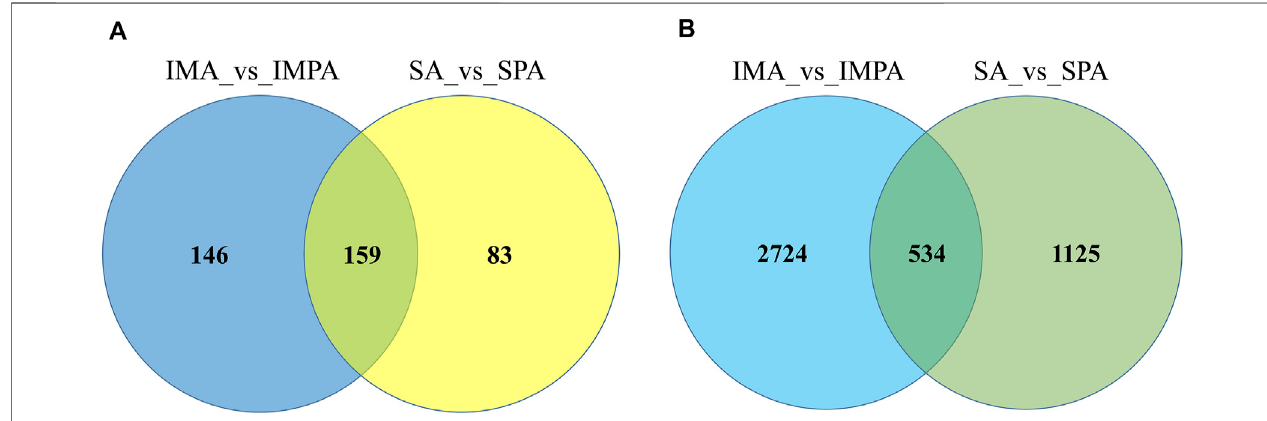
FIGURE 5 | Venny maps of differentially expressed RNAs. Venny maps showing speci fi c miRNAs (A) and mRNAs (B) , respectively, in intramuscular adipocytes or subcutaneous adipocytes.